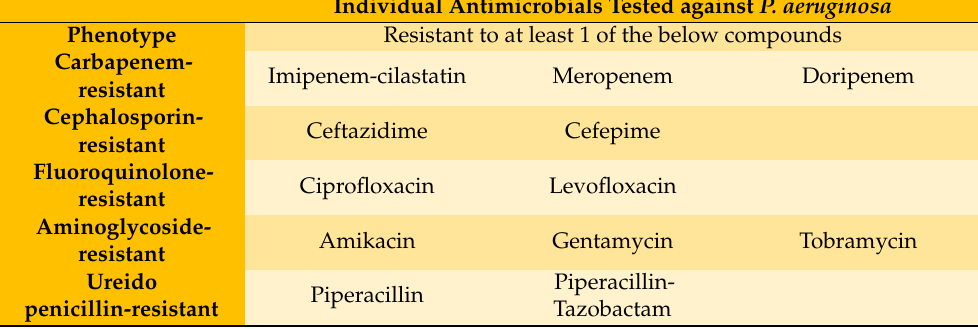
Table 1. Pseudomonas aeruginosa resistance based of antibiotic classes. Individual Antimicrobials Tested against P.